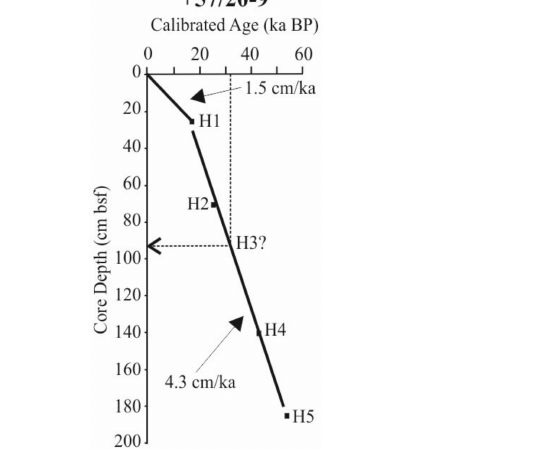
Figure 8. Sedimentation rates based on the correlation between the HL identified in the + 57 / 20-9 core and the published calibrated ages for the HE [30,36,37,44]. Two lineal regressions have been calculated to obtain sedimentation rates depending on the climatic